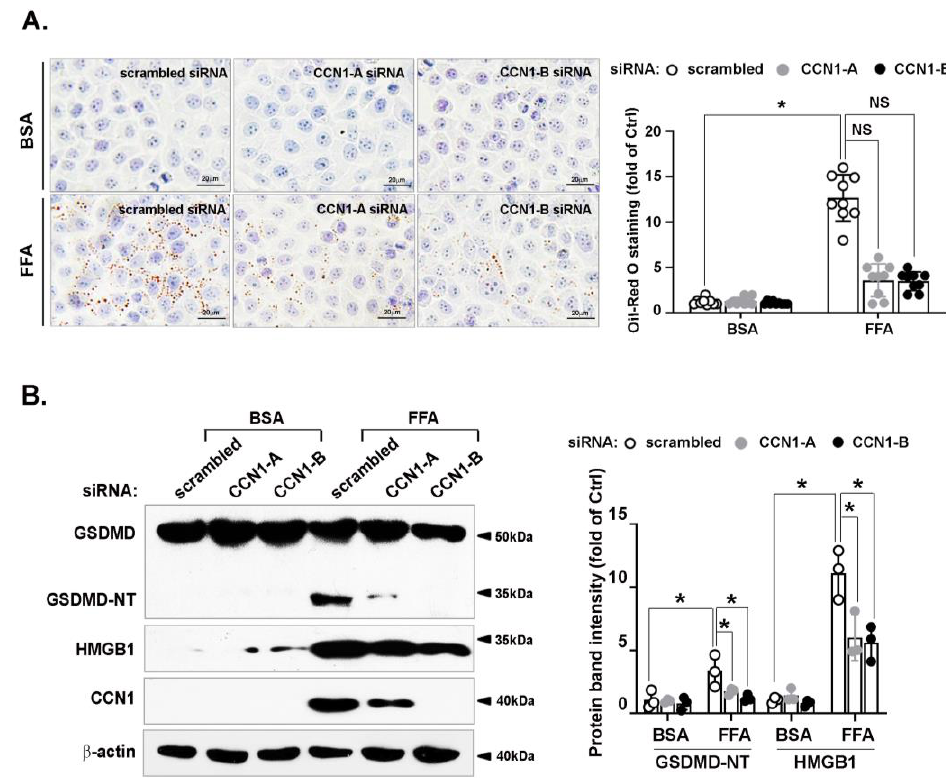
Figure 3. Effects of CCN1 on FFA-induced intracellular lipid accumulation and pyroptosis in hepatocytes. LO2 hepatocytes were transfected with a scrambled siRNA or two pairs of CCN1 siRNAs (CCN1-A and CCN1-B), then incubated with FFA (1 mM). ( A ) Prior to harvest, LO2 hepatocytes were stained with oil red O for 1 h. Images shown are representative of three independent experiments performed in triplicate (left). The quantification of lipid content was performed after isopropanol extraction (right). ( B ) Protein levels of GSDMD, HMGB1, CCN1, and β -actin in the cell lysates were analyzed by immunoblotting. Immunoblots shown are representative of three independent experiments. Quantifications of band intensity were normalized to β -actin. * p < 0.05, NS: not significant.